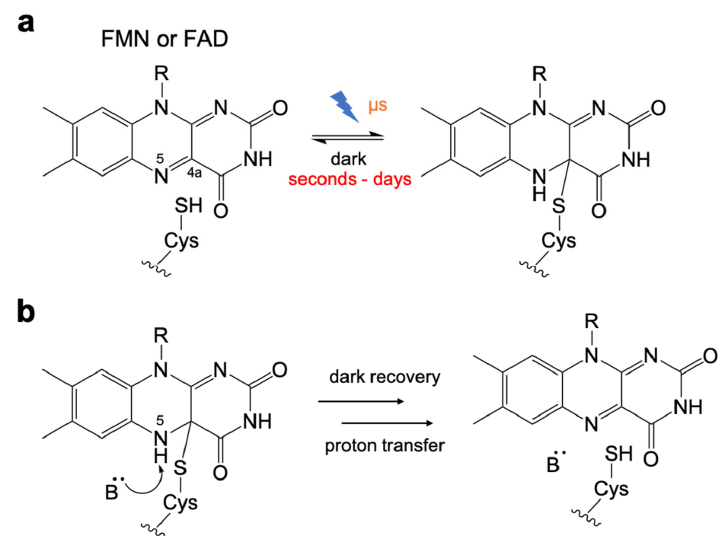
Figure 2. Photochemistry of LOV domain. ( a ) The photochemistry of flavin chromophore. Upon illumination, a reversible thioether bond is formed between the flavin C4a position and the thiol of cysteine. ( b ) Base-catalyzed cleavage for dark recovery. Cys-flavin adduct cleavage process is assisted by deprotonation of the flavin N5 position.